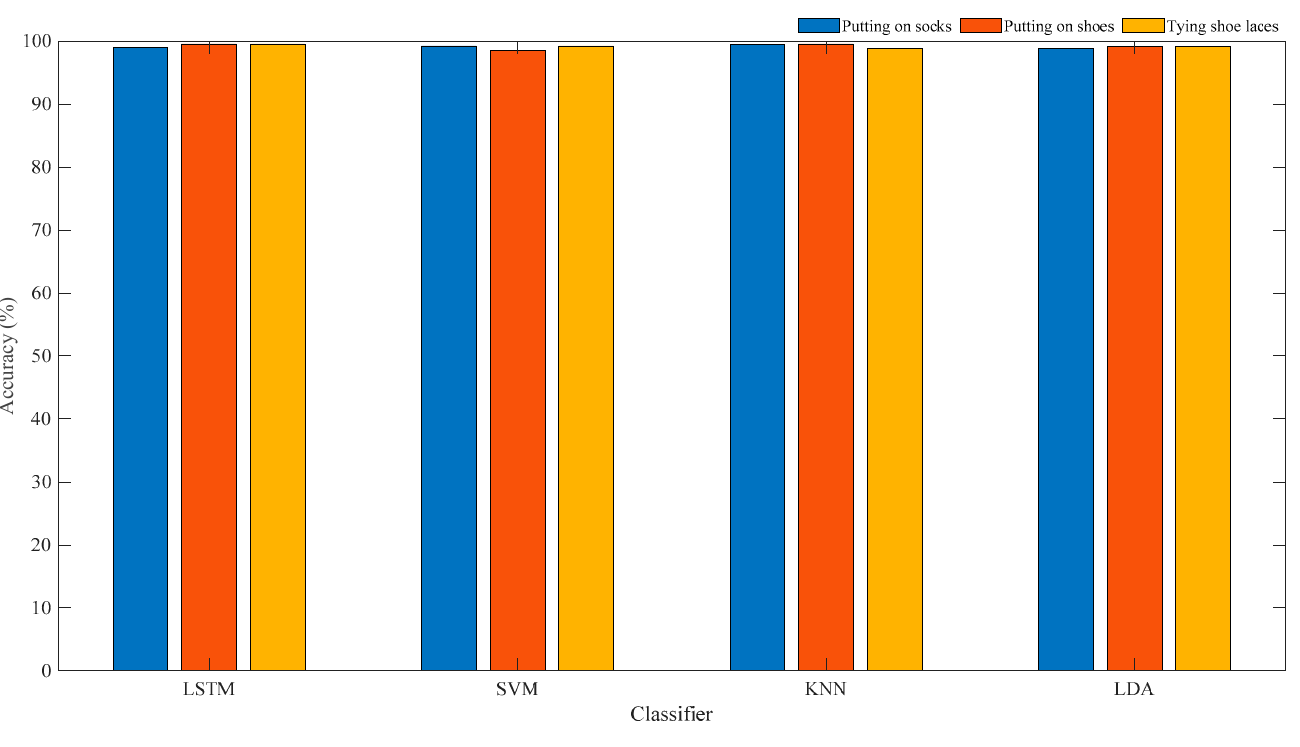
Figure 7. The recognition results of each classifier. Table 4. The recognition results of each